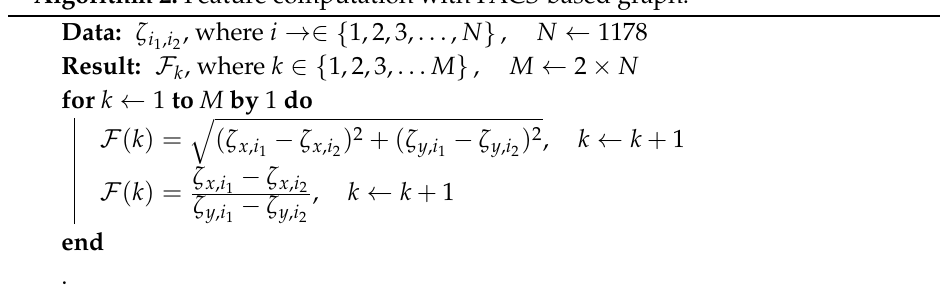
Algorithm 2: Feature computation with FACS-based